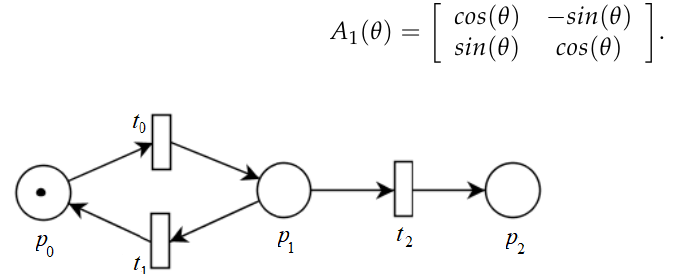
Figure 6. QPN model of a while loop.